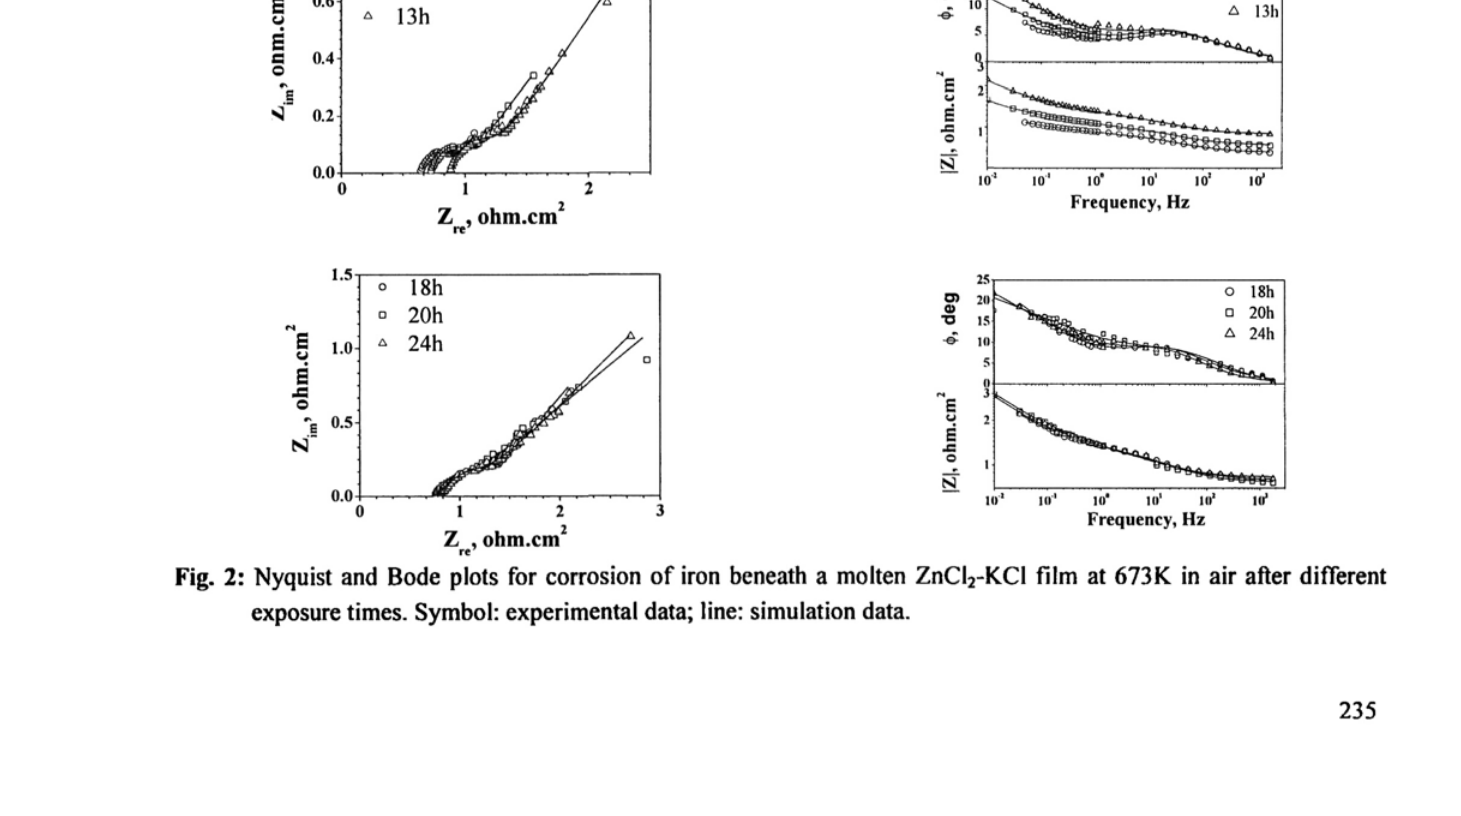
Fig. 2: Nyquist and Bode plots for corrosion of iron beneath a molten ZnCI exposure times. Symbol: experimental data; line: simulation